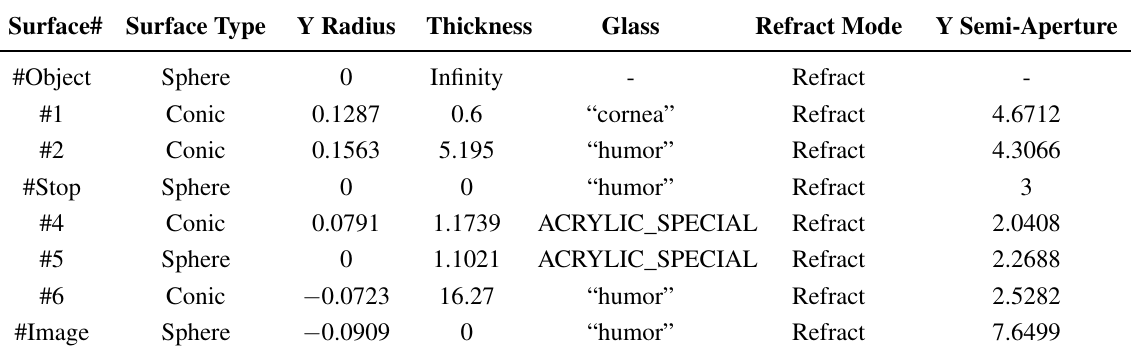
Table 7. The lens parameter after proposed GA optimization for pupil size 6 mm.